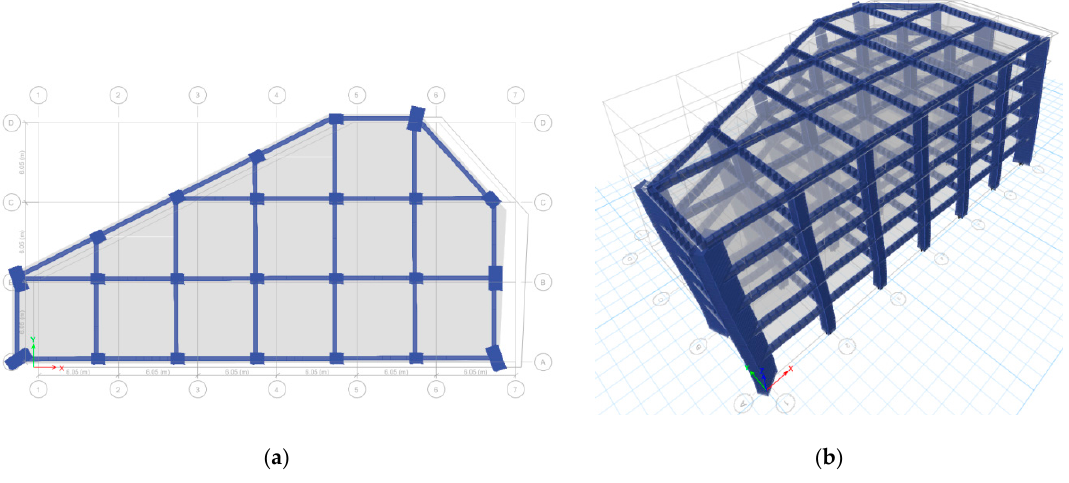
Figure 12. The 1st mode shape for T 1 = 0.451 s: ( a ) plane view, and ( b ) 3D view. Table 10. Ratios of the modal participating mass after the reducing of the torsion.